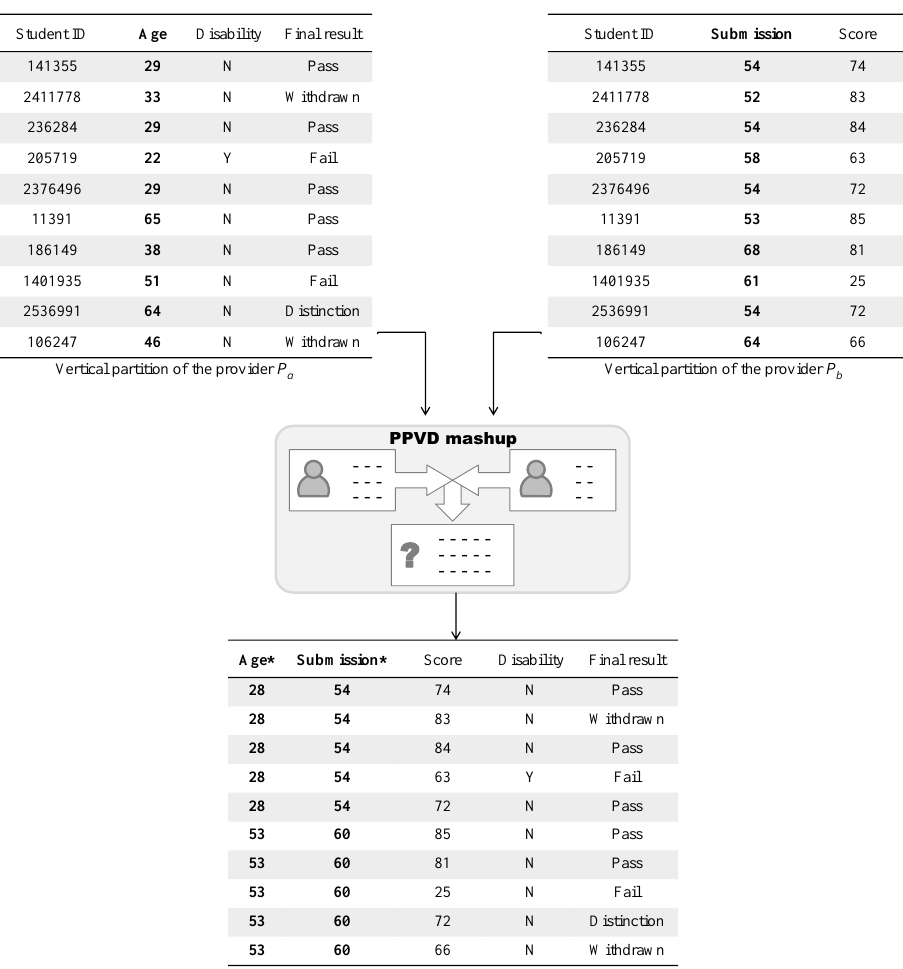
Figure 2. Execution result of the PPVD mashup protocol on an excerpt of 10 records. Quasi-identifier attributes are marked in bold. The asterisk identifies the masked